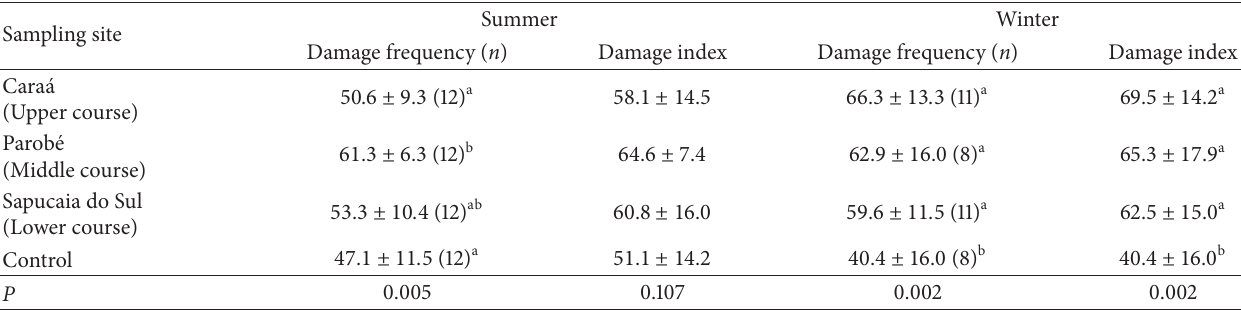
Table 2: Damage frequency (the sum of cells with damage classes 1 to 4, in %) and damage index estimated by the comet assay (mean ± standard deviation) in the erythrocytes of H. luetkenii exposed to water samples from the Sinos River and to tap water